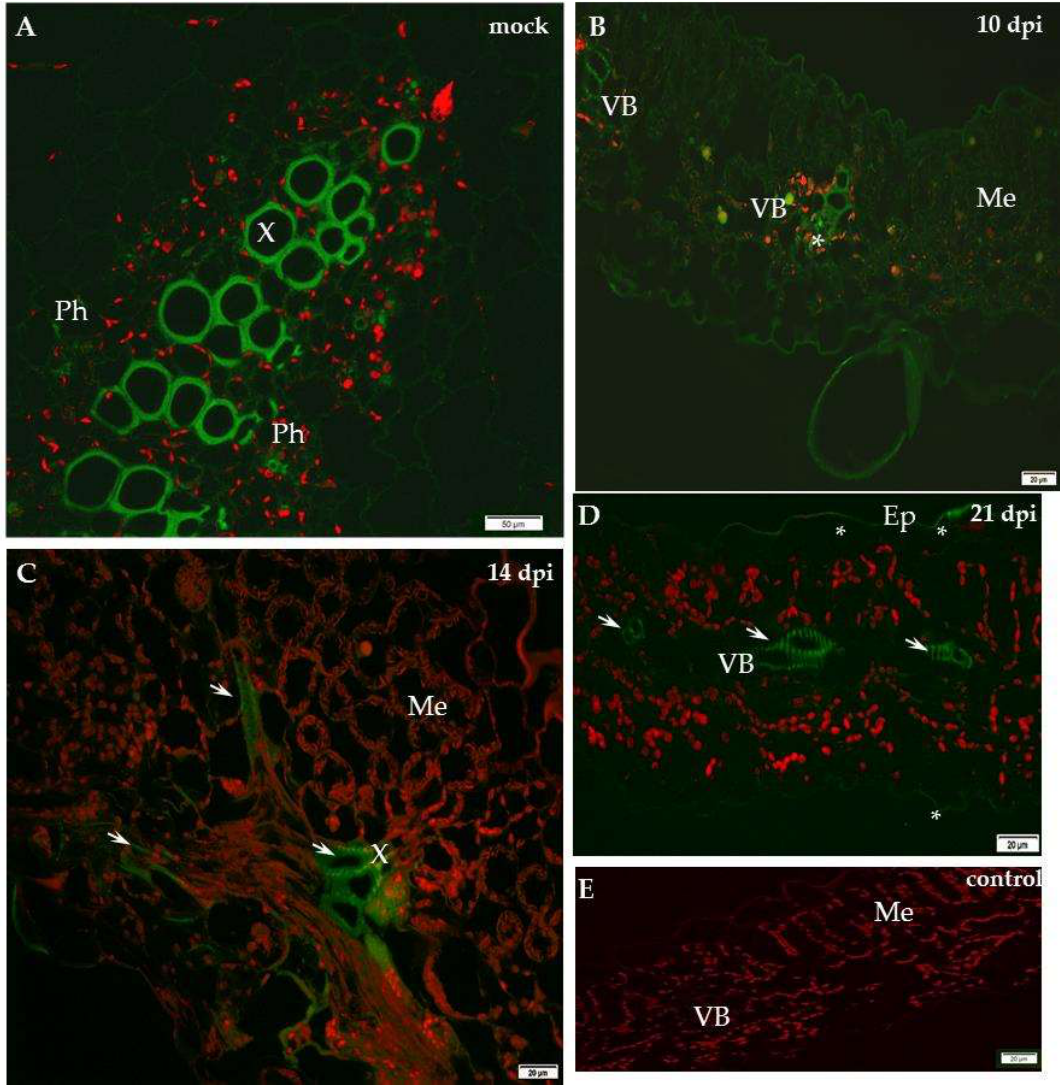
Figure 6. Immunofluorescence localisation of xyloglucan xyloglucosyl-transferase (XTH-Xet5) during potato–PVY NTN compatible interaction. ( A ) Green fluorescence signal of XTH-Xet5 in xylem and phloem elements of mock-inoculated potato Irys leaf petiole. Bar 50 µm. ( B ) Fluorescence detection of XTH-Xet5 in xylem, phloem parenchyma (*) and weaker signal in the mesophyll of Irys leaflets 10 days post-virus inoculation. Bar 20 µm ( C ) Fluorescence detection of XTH-Xet5 in xylem (arrows) 14 days post-PVY inoculation. Bar 20 µm ( D ) Detection of XTH-Xet5 in xylem (arrows) and epidermis (*) 21 days post-PVY inoculation. Bar 20 µm ( E ) Lack of green fluorescence signal when primary antibodies were omitted–control. Bar 20 µm. Ep—epidermis, Me—mesophyll, Ph—phloem, VB—vascular bundle, X—xylem.